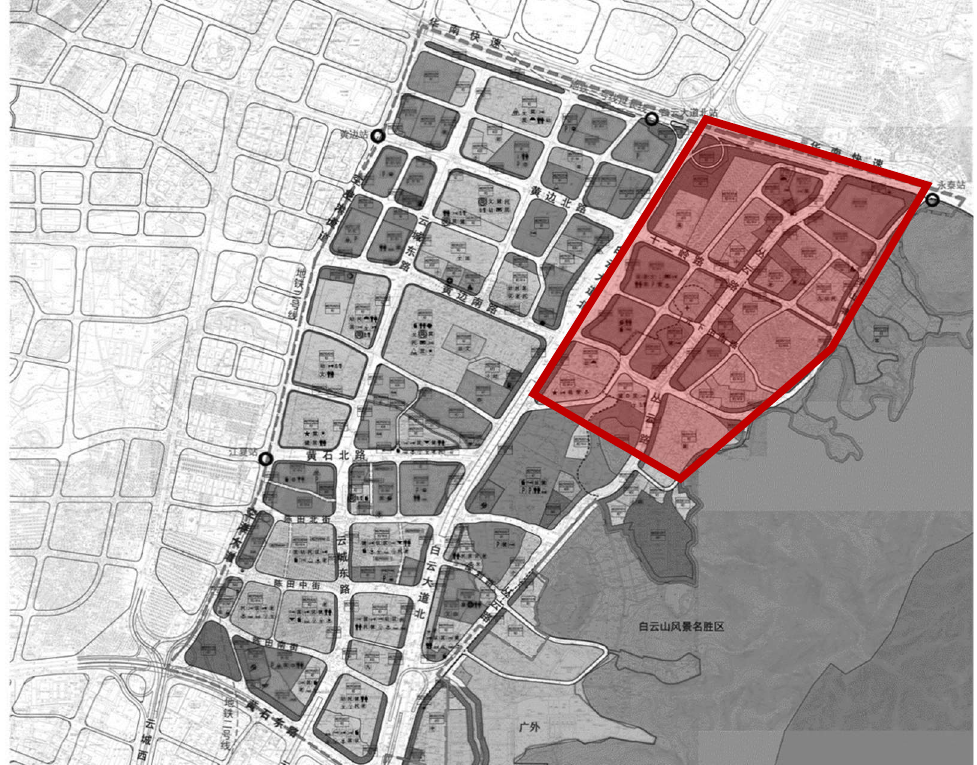
Figure 3. The location of the Yongtai community (Source: Adapted with permission from Ref. [67]. 2016, Guangzhou Municipal Planning and Natural Resources Bureau).